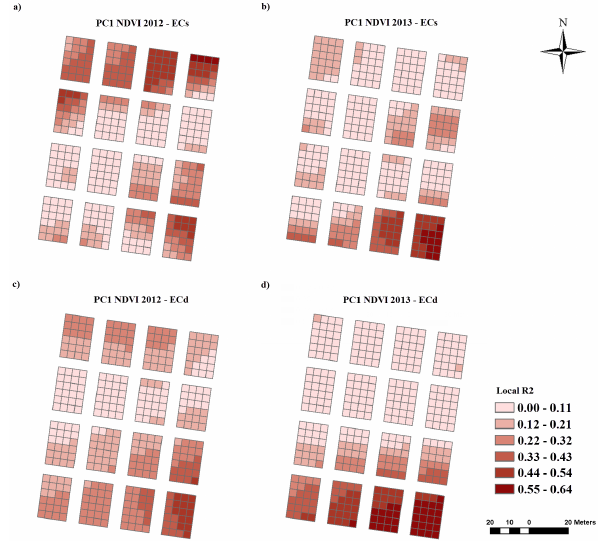
Figure 10. Local R 2 of GWR analyses: (a) first principal compo- nent of NDVI in 2012 and ECs of 2011; (b) first principal compo- nent of NDVI in 2013 and ECs of 2011; (c) first principal compo- nent of NDVI in 2012 and ECd of 2011; (d) first principal compo- nent of NDVI in 2013 and ECd 2011.